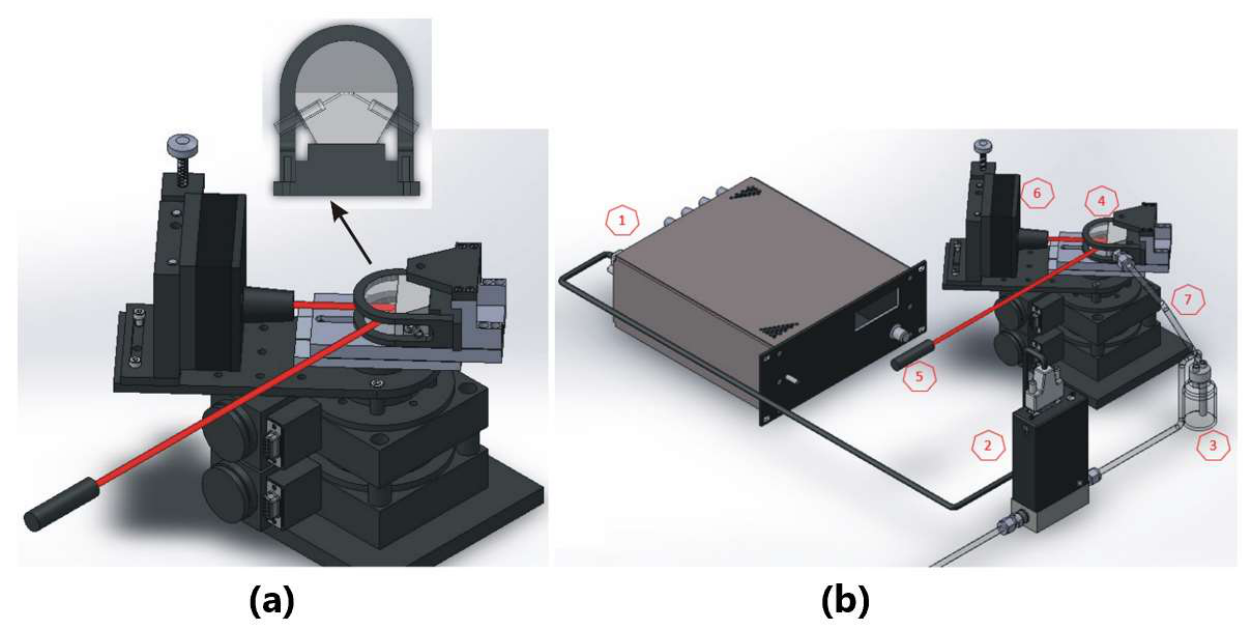
Figure 1. ( a ) Experimental setup of the SPR sensor for angular interrogation (liquid samples) and ( b ) SPR scheme for intensity interrogation approach (gaseous samples). The system is integrated by a (1) mass flow controller, (2) metal-sealed pressure flow controller, (3) sample container, (4) silver- coated prism coupled to flow cell, (5) He-Ne laser, (6) photodetector, and (7) stepper rotating stage.